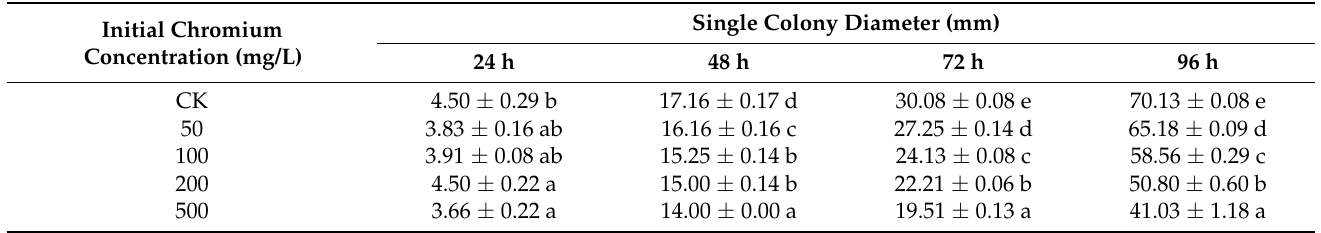
Table 2. Single colony diameters of A. niger strain A1 during exposure to different Cr 6+